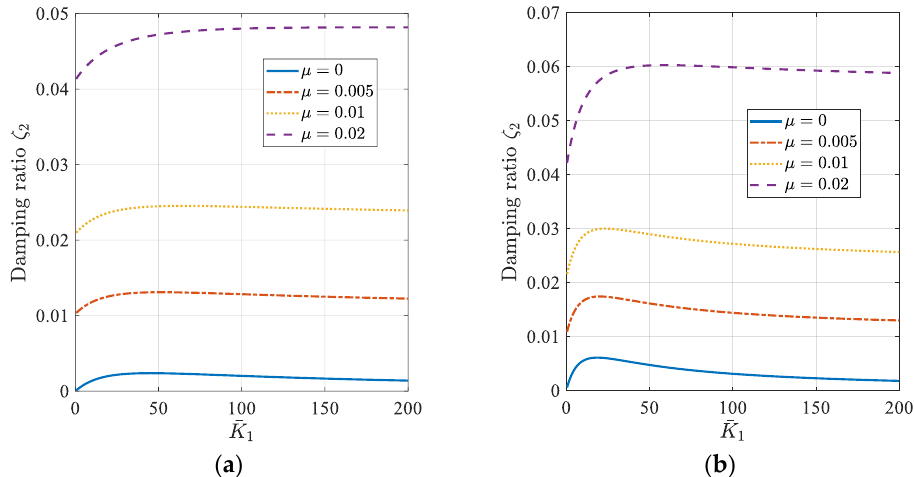
Figure 7. Second modal damping of a cable with two dampers versus the HDR damper stiffness 𝐾̅ 1 ( 𝜑 = 0.5,𝜌 = 0.5, 𝑥 2 /𝐿 = 0.25), with ( a ) 𝑥 1 /𝐿 = 0.02 and ( b ) 𝑥 1 /𝐿 = 0.05. ( ϕ = 0.5, ρ = 0.5, x 2 / L = 0.25), with ( a ) x 1 / L = 0.02 and ( b ) x 1 / L =